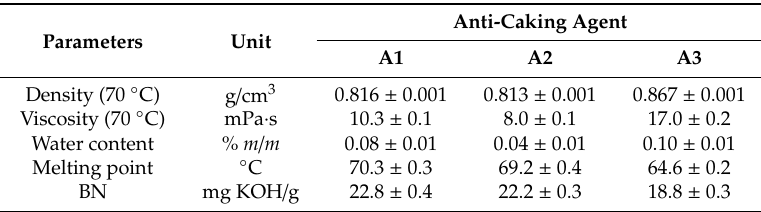
Table 2. Physical and chemical parameters of anti-caking